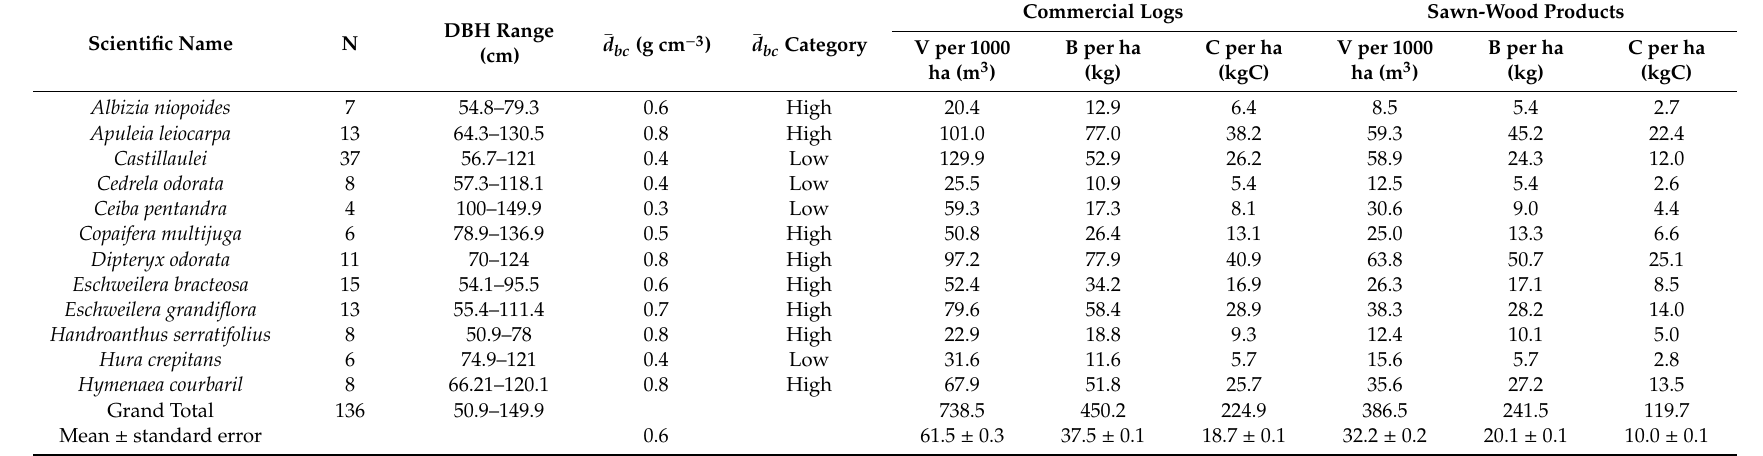
Table 2. Scientific name, number of trees sampled per species (N), diameter range (diameter at breast height—DBH), mean basic density of wood with bark ( d bc ) in g cm − 3 , volume (V) in m 3 per 1000 ha biomass (B) in kg ha − 1 , and carbon (C) in kgC ha − 1 of products and of commercial logs for the twelve species in a 1252.8 ha area harvested in a forest-management area in the state of Acre,